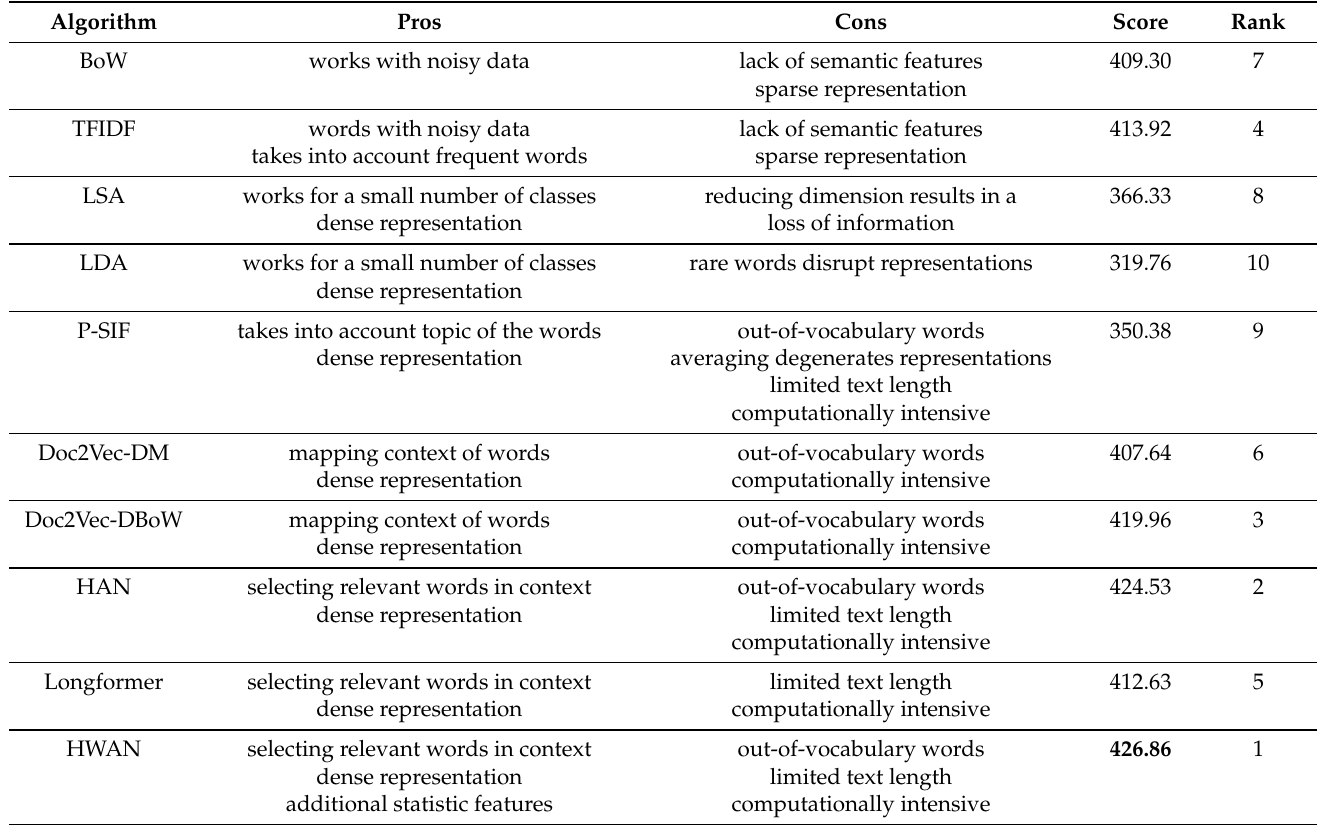
Table 6. Pros and cons of presented methods. Score is calculated as the sum of the accuracy for all datasets. Algorithm